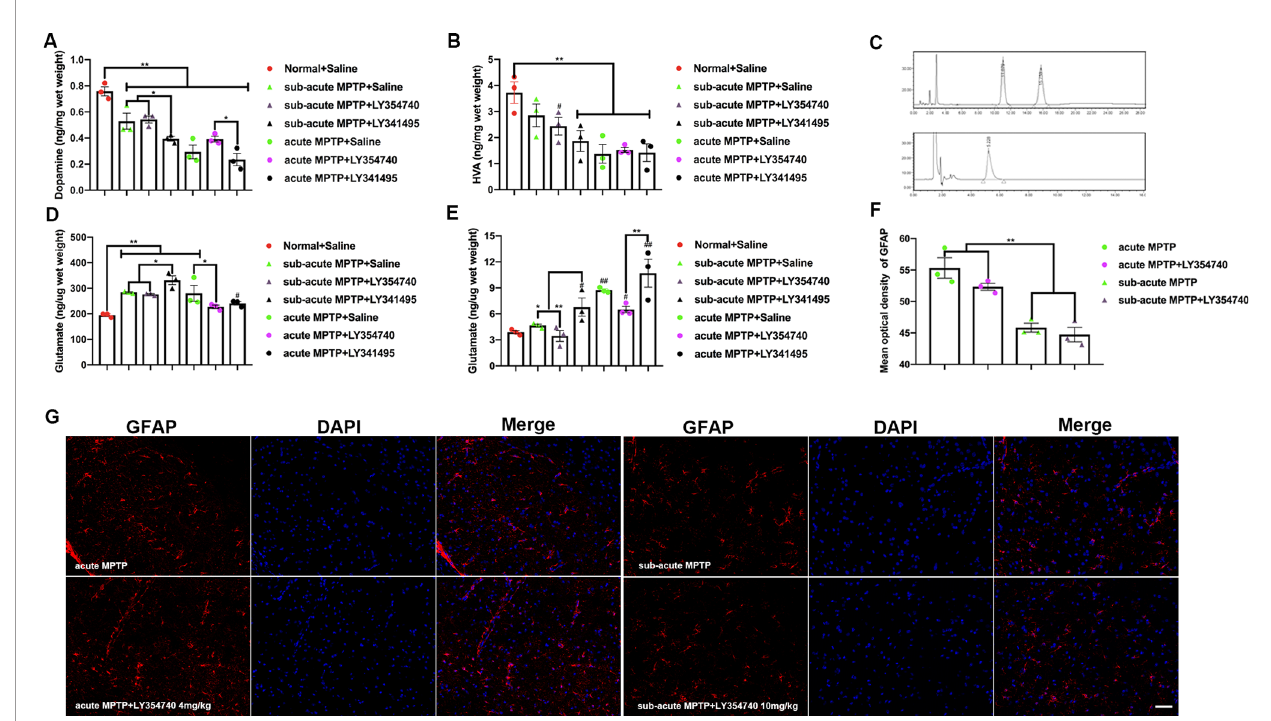
FIGURE 2 | Ligands of mGlu 2/3 receptors regulate the levels of dopamine (DA), homovanillic acid (HVA), and glutamate in 1-methyl-4-phenyl-1,2,3,6- tetrahydropyridine (MPTP) treated mice. Levels of DA (A) and HVA (B) detected in the striatum and levels of glutamate detected in the (D) substantia nigra (SN), (E) striatum. Data are expressed as ng/µg or ng/mg wet weight tissue and represent the mean ± SEM (n = 3). # p < 0.05, ## p < 0.01 compared to the normal + saline group; *p < 0.05, **p < 0.01. (C) Sample chromatogram of standard solution. Peaks in order: DA (11 min), HVA (15 min). Illustration of the glutamate standard peak (5 min). (F , G) Optical density analysis and immuno fl uorescence of glial fi brillary acidic protein (GFAP) in SN. Scale bar = 50 µm. **p < 0.01. N = 3. Error bars represent